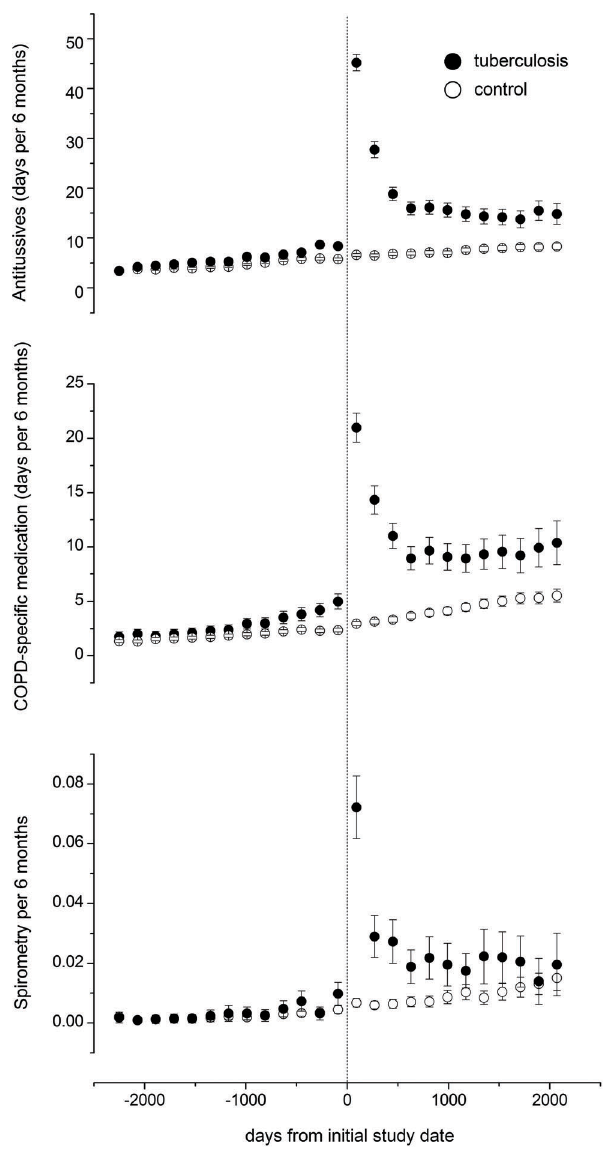
Figure 2. Prescription of antitussives, chronic obstructive pulmonary disease (COPD)-specific medication, and spirome- try in tuberculosis patients and control subjects. Prescription data aggregated every 6 months from the individual initial study date and presented as mean (circle) and 95% confidence interval (error bar).